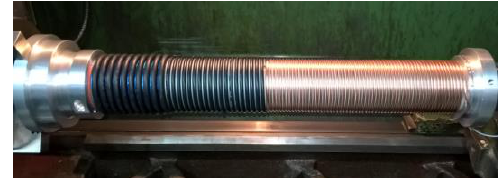
Fig. 2. View of the multi-section coil of the FCG